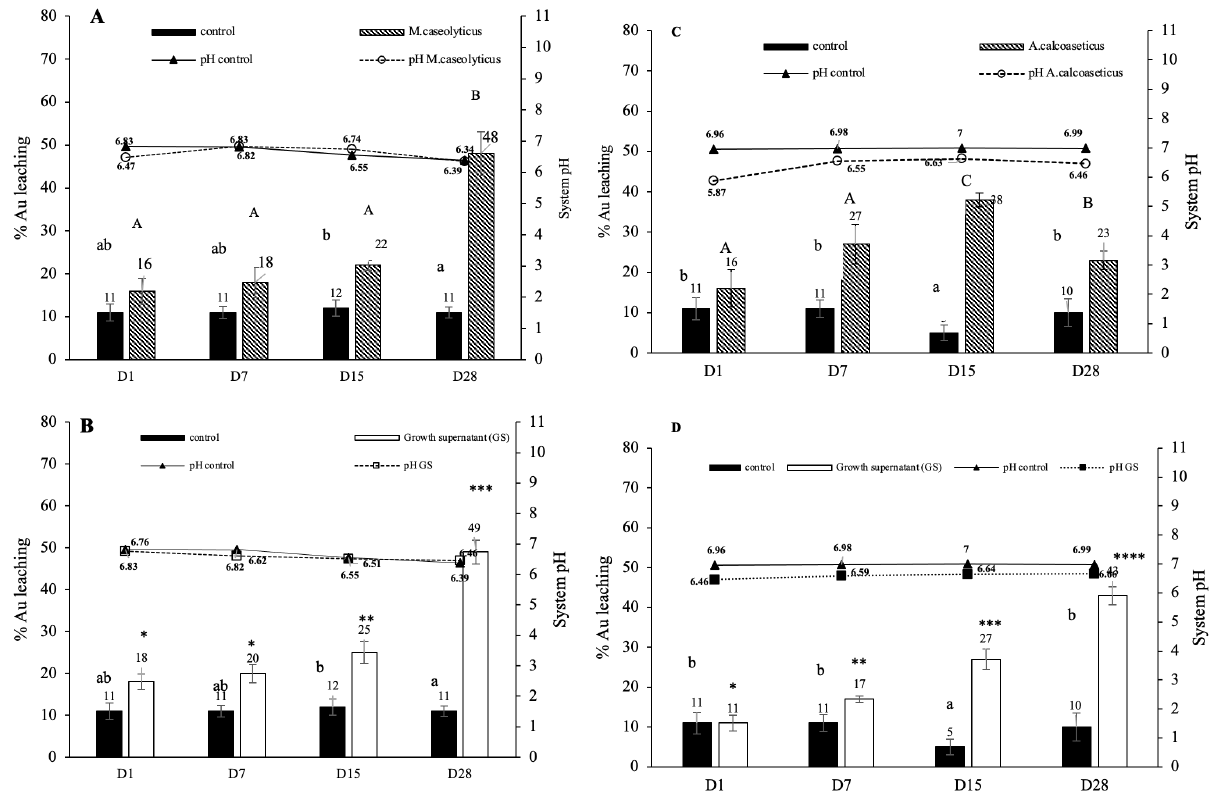
Figure 4. Gold bioleaching from silicate ores by M. caseolyticus in the minimal medium under ( A ) in the presence of microorganisms and ( B ) growth supernatant conditions and by A. calcoaceticus in ethanol mineral salt medium under ( C ) in the presence of microorganisms and ( D ) growth supernatant conditions. The flasks were shaken at 150 rpm, 30 ◦ C, and the particle size of ores was approximately ≤ 75 µ m. Data were expressed as the mean ± SD ( n = 3) and analyzed by Duncan’s test ( p < 0.005). The lower-case letters, capital letter and asterisks (*) were compared percentage of gold (Au) leaching by medium (control), in the presence of micro-organism and growth supernatant condition at various time. Table 2. Amino acid content of growth supernatant by M. caseolyticus before and after gold bioleaching. Amino